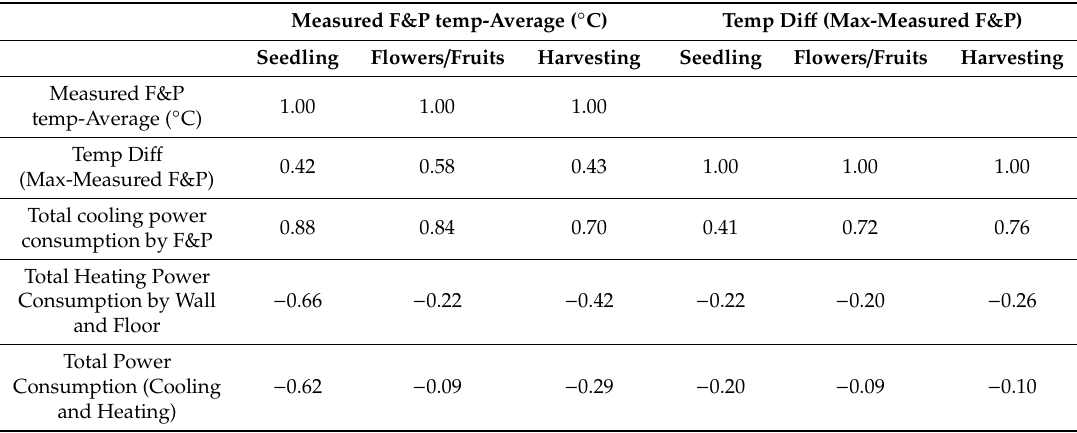
Table 3. Correlation between key variables and measures in three stages of the capsicum